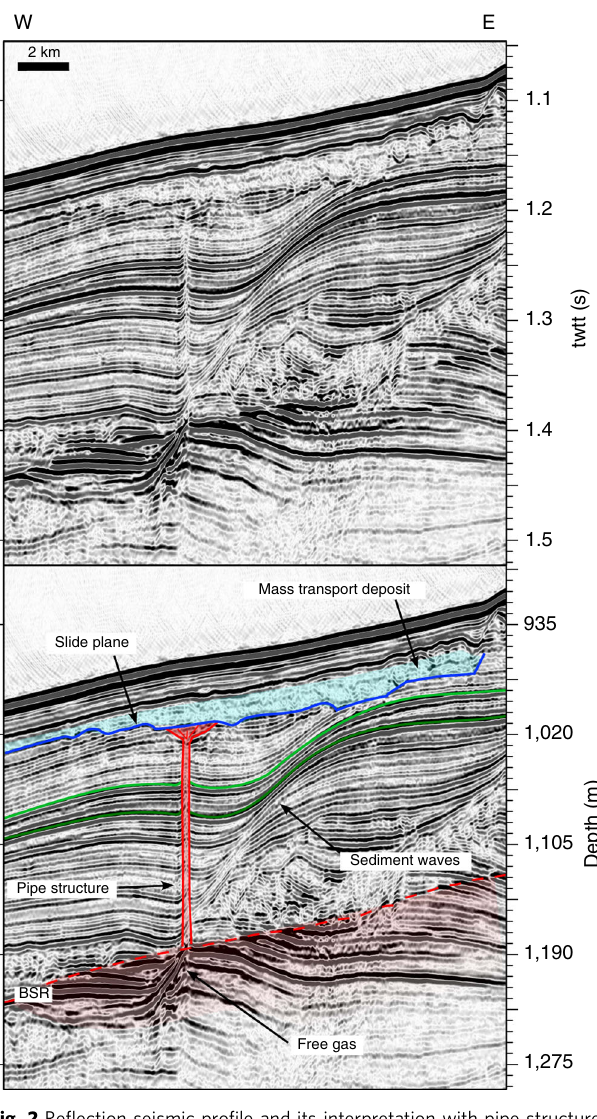
(Fig. 3 and Table 1). At the top of the pipe structure (~ 45 mbsf),